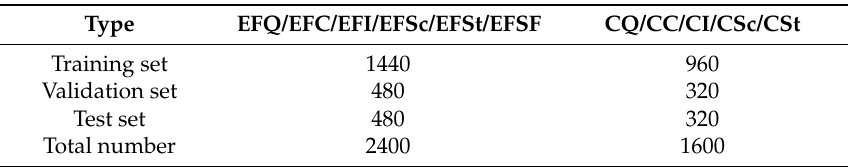
Table 3. Distribution of 11 categories of roller datasets.